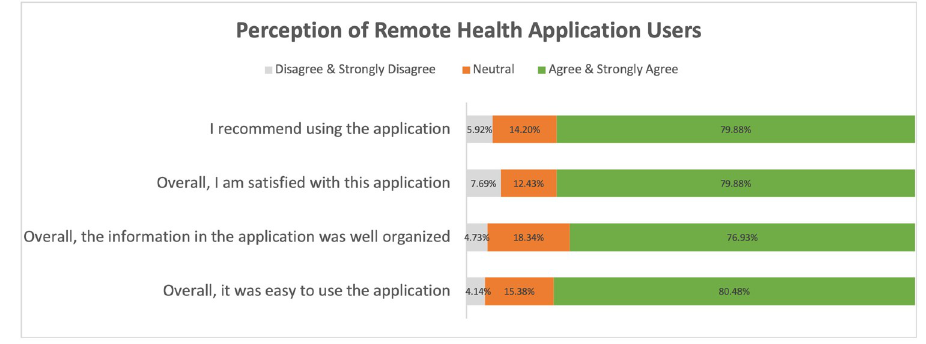
Fig 1. Perception of remote health application